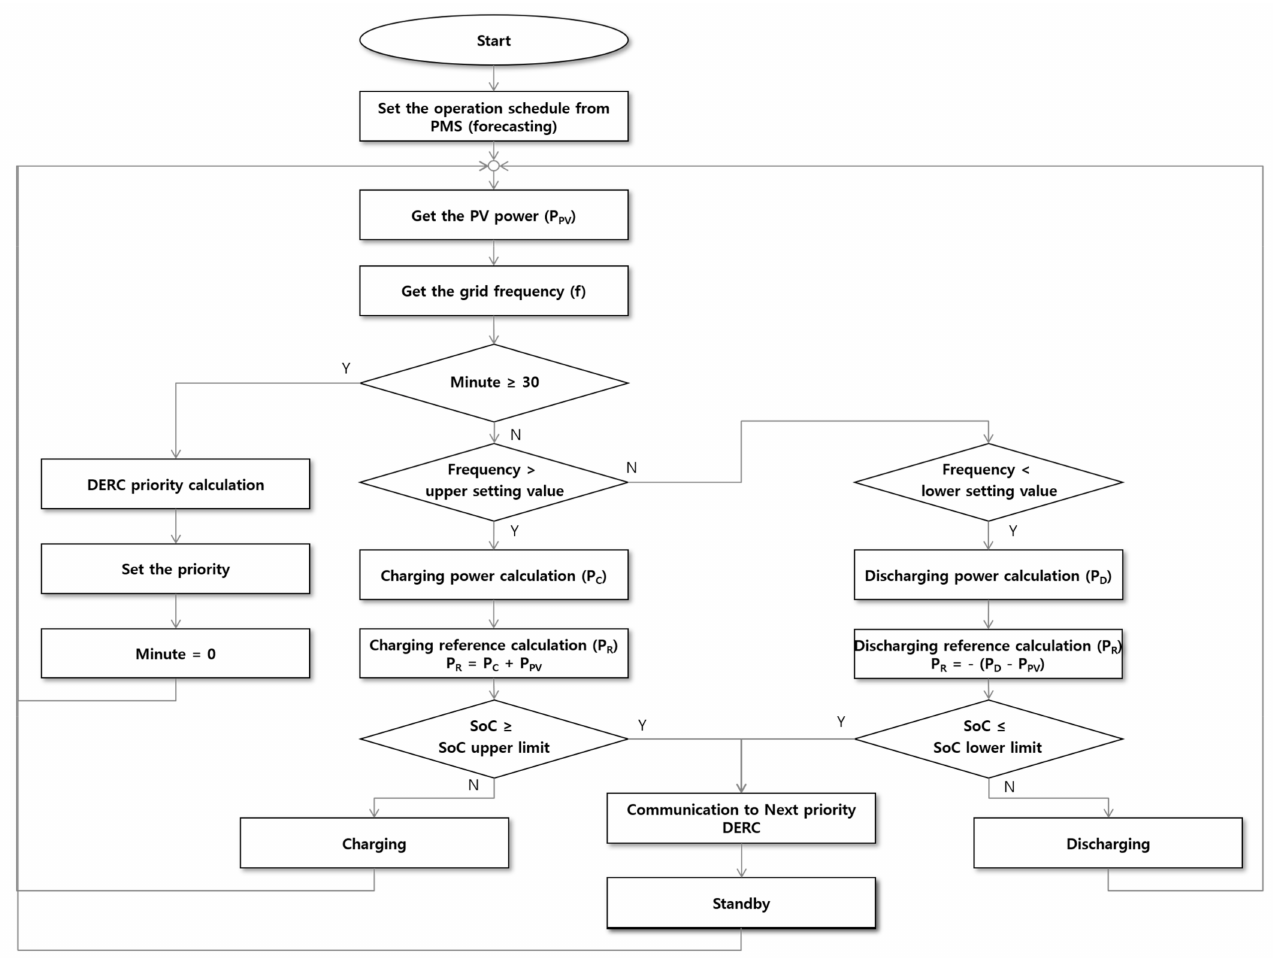
Figure 6. Flowchart of the proposed method.